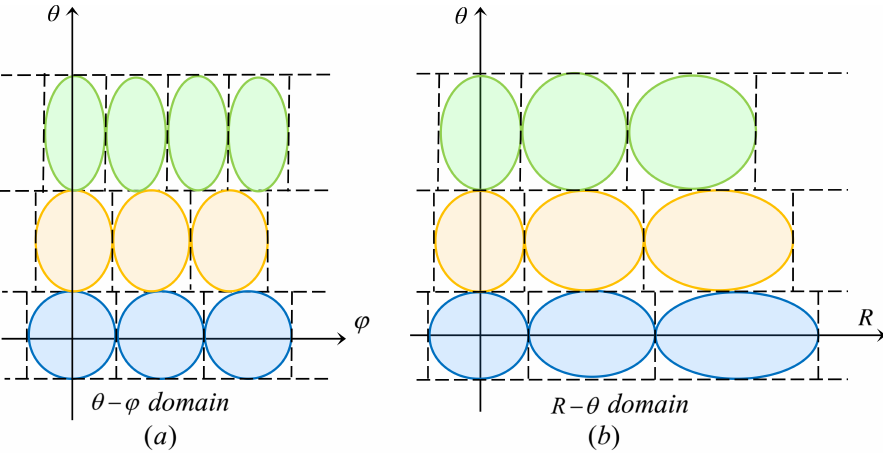
Figure 4. Illustration of the TAA. ( a ) θ − ϕ domain. ( b ) R − θ domain. To cover the whole communication serving zone with a relatively small codebook size, each beam ellipsoid must be tangent to the surrounding ellipsoid. We already know that the design of R domain is independent of ϕ domain and vice versa. So if we can guarantee that the ellipses are tangent in the 2D domain ( θ − ϕ domain and R − θ domain), then the ellipsoid must be tangent in the 3D domain ( R − θ − ϕ